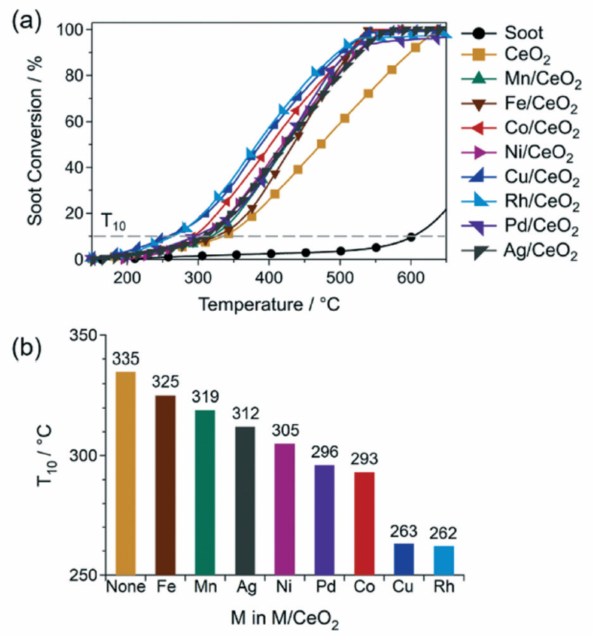
Figure 8. ( a ) Soot conversion versus temperature. ( b ) T 10 in the presence of M/CeO 2 catalysts under a flow of 0.5% O 2 . Reproduced with permission of reference